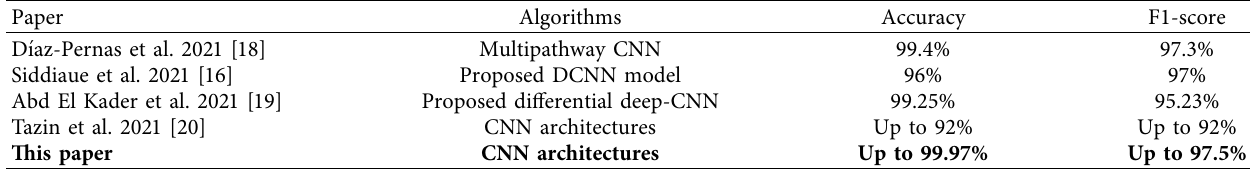
Table 8: Accuracy and F1-score comparison with other previous